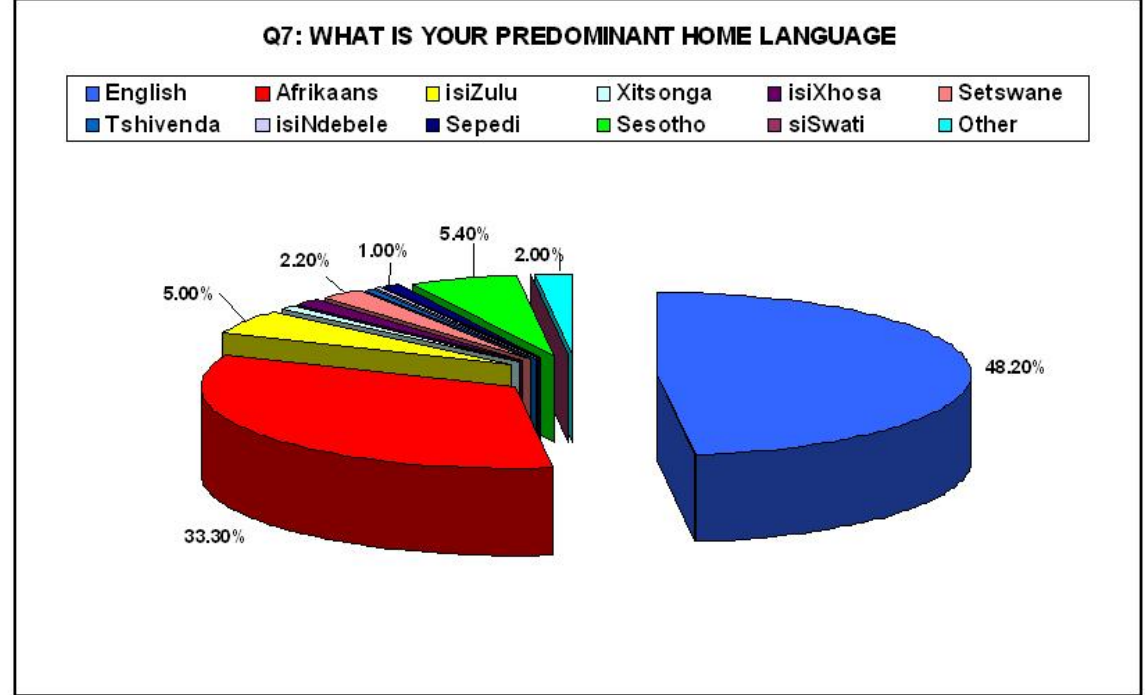
Figure 5 Representation of the responses to Question 7 of the